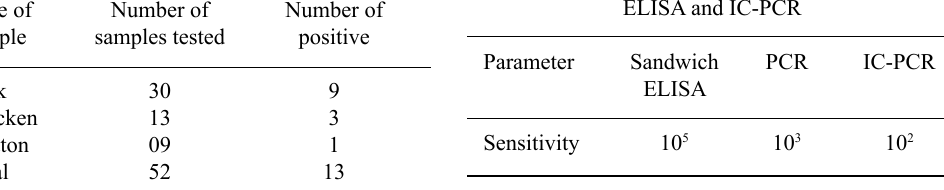
table 5. Comparison of